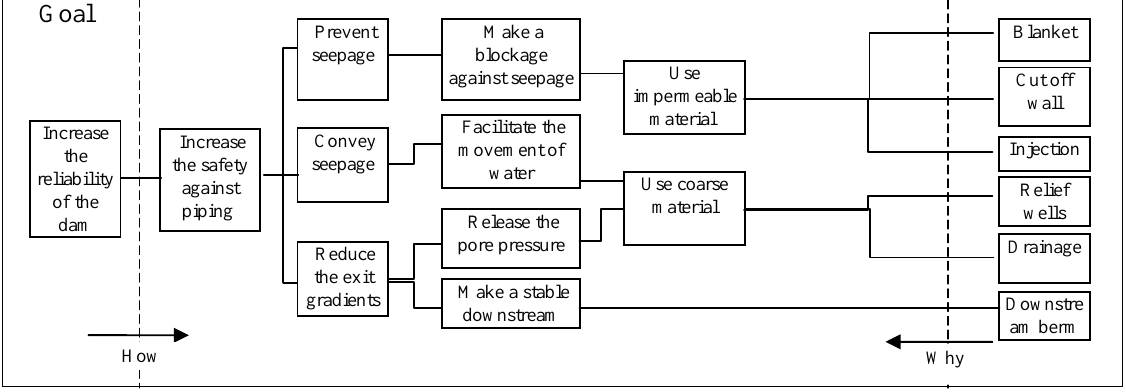
Fig. 5. FAST diagram for the dam